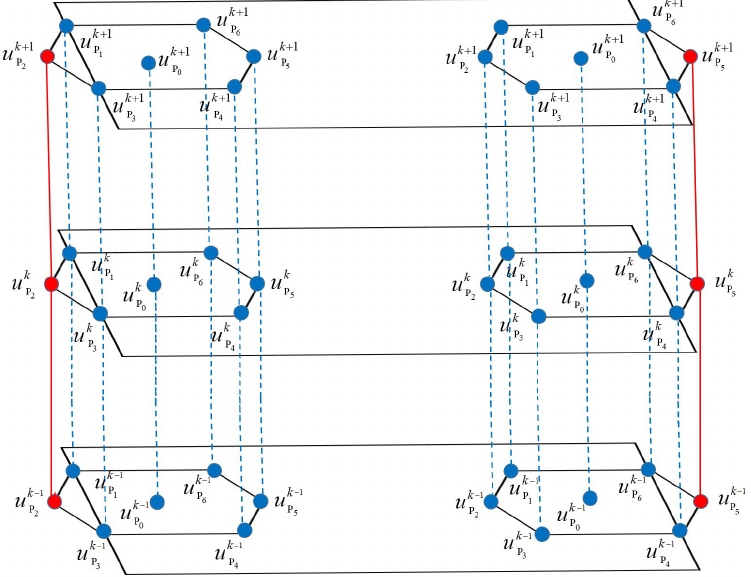
Figure 1. The illustration of the exact solution at the irregular hexagons with a ghost point at time levels t − τ , t and t + τ